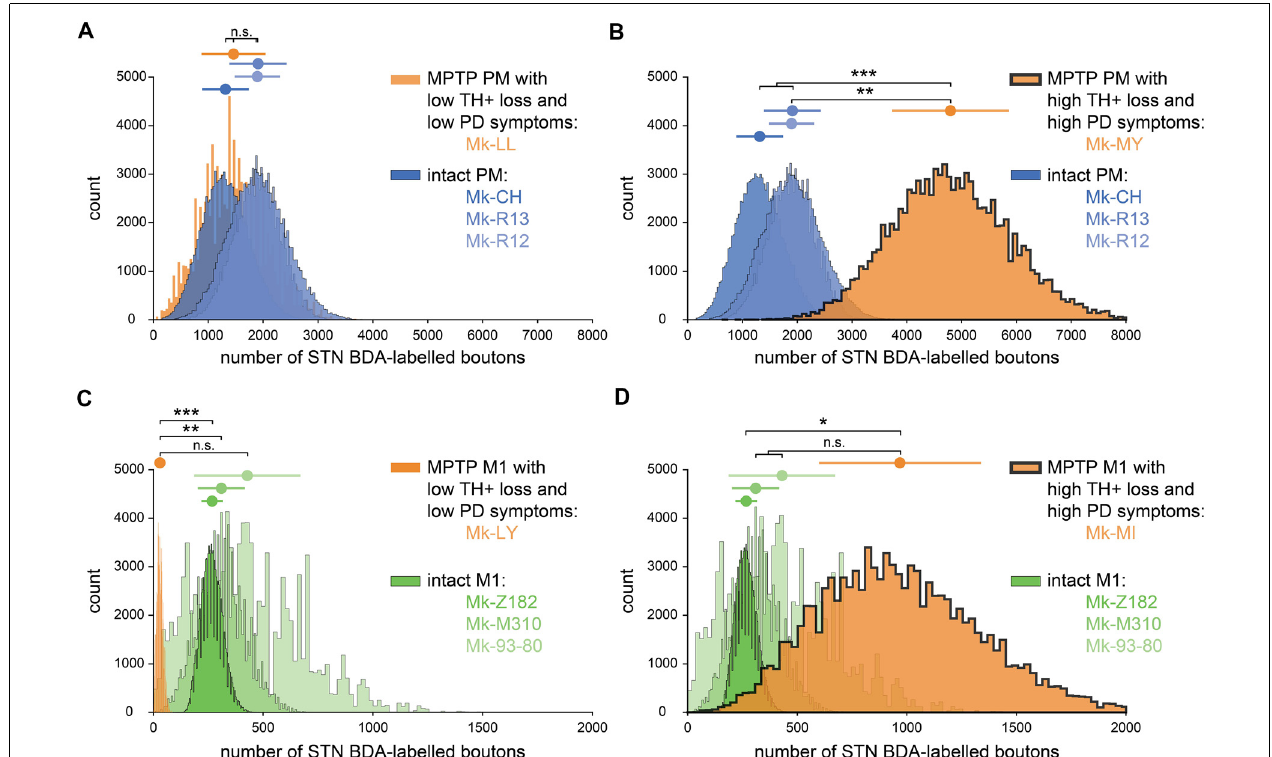
FIGURE 4 | Bootstrapped distributions (see “Materials and Methods” section) with the mean (dot) ± standard deviation (bars) of the corrected and normalized numbers of corticosubthalamic boutons observed in STN in the 10 monkeys injected with BDA. (A) Comparison between the intact animals injected in PM (blue) with Mk-LL (MPTP animal injected in PM, orange). (B) Same as (A) but compared to Mk-MY. (C) Comparison between the intact animals injected in M1 (green) with Mk-LY (MPTP animal injected in M1, orange). (D) The same as (C) but compared with Mk-MI. (A–D) Statistical analysis (see “Materials and Methods” section) comparing each animal with all the three others (four groups in total). Statistically significant differences (Bonferroni correction for multiple-group comparisons) are indicated as follows: * p < 0.0125; ** p < 0.0025, *** p < 0.00025; “n.s.” refers to statistically non-significant ( p >